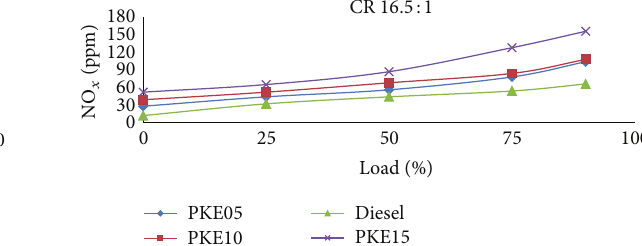
Figure 17: Load versus NO 𝑥 emissions at 16.5 :1